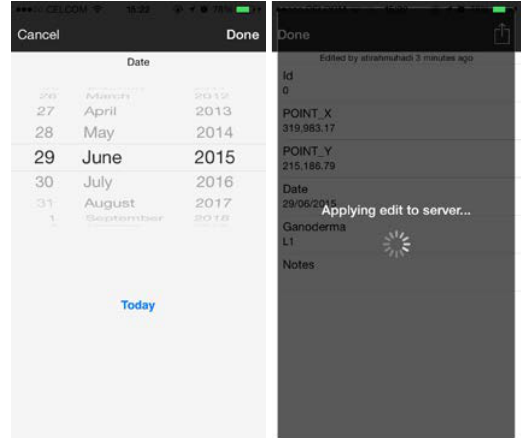
Figure 3. Sreenshots of recording the date of data collection and saving the edits to the server